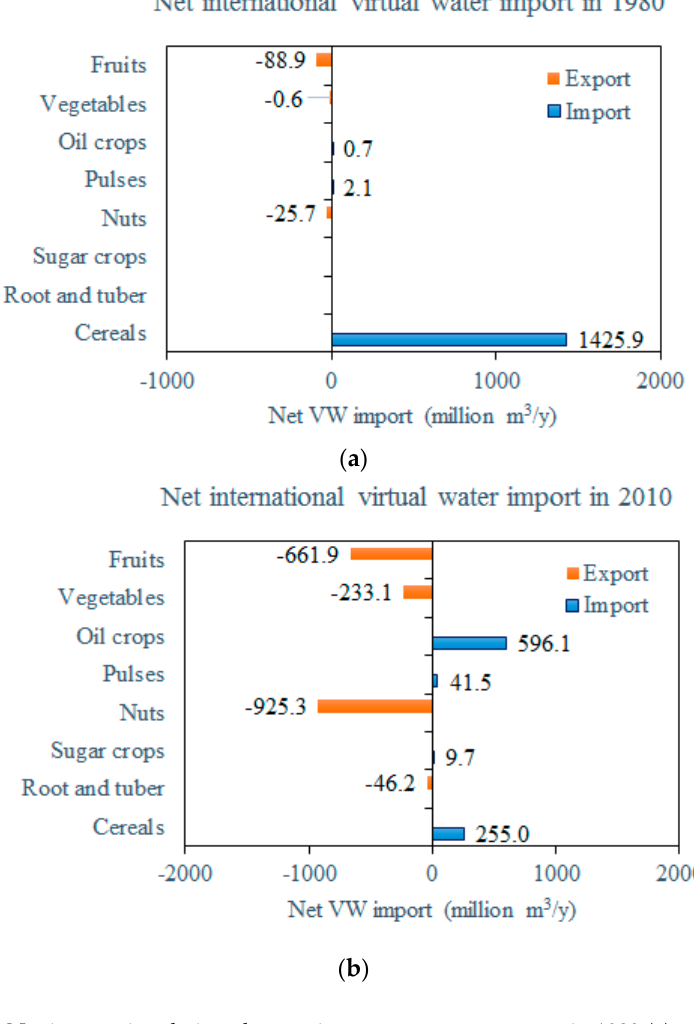
Figure 11. Net international virtual water import per crop category in 1980 ( a ) and 2010 ( b ).